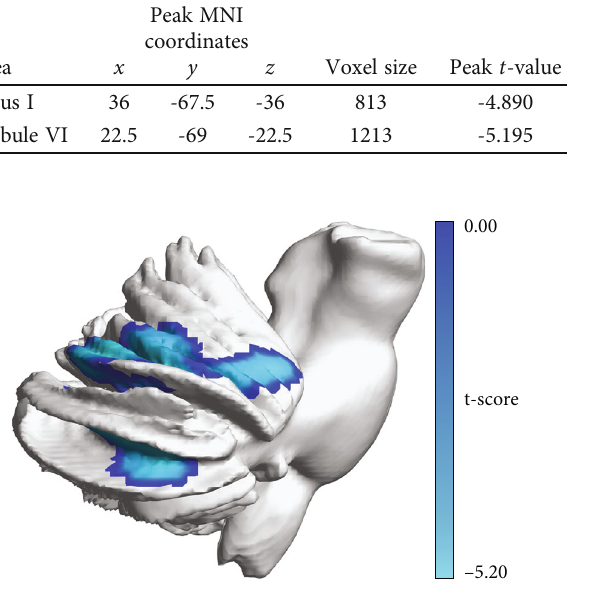
Figure 2: Resulting clusters of VBM